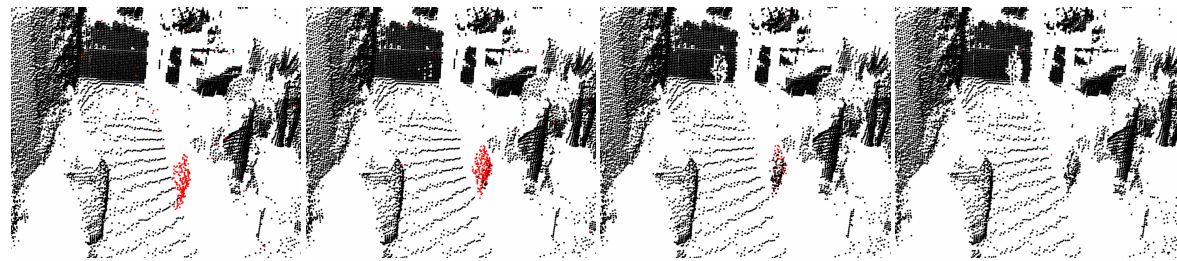
Figure 8. Transition of a region from the foreground (red) to the background (black), while a pedestrian stopped and stood in place for a longer